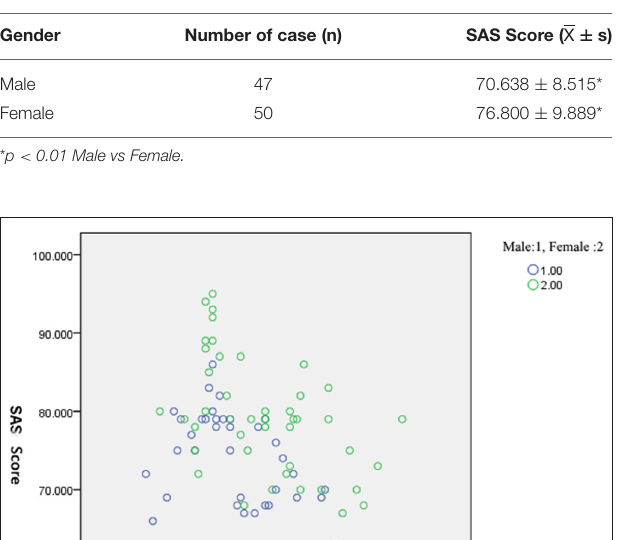
TABLE 1 | Influence of gender on SAS scores.